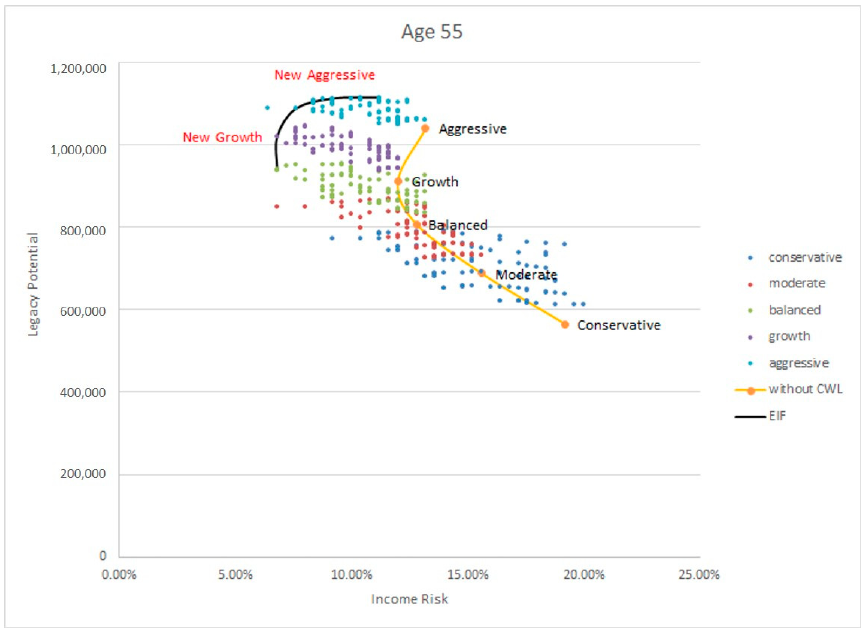
Figure 3. Income risk versus legacy potential for all portfolios and Efficient Income Frontier (EIF).